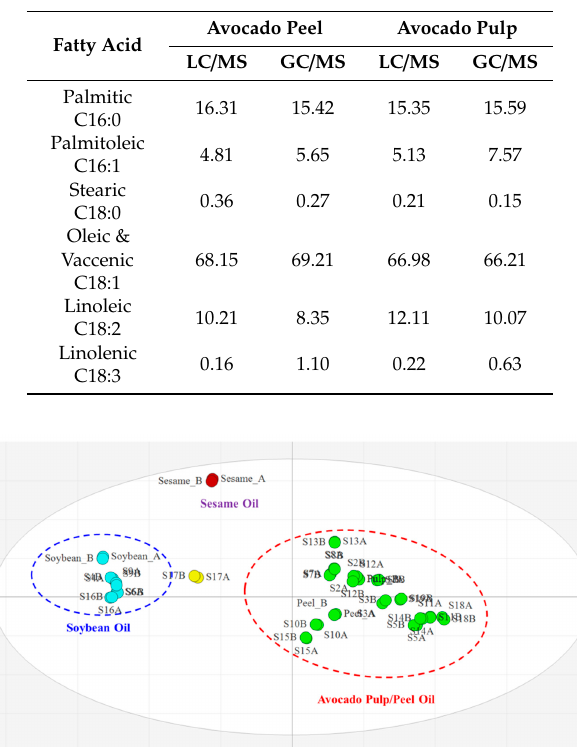
Table 5. Comparison of concentrations (weight %) of individual FA calculated from UHPLC / MS and GC / MS.